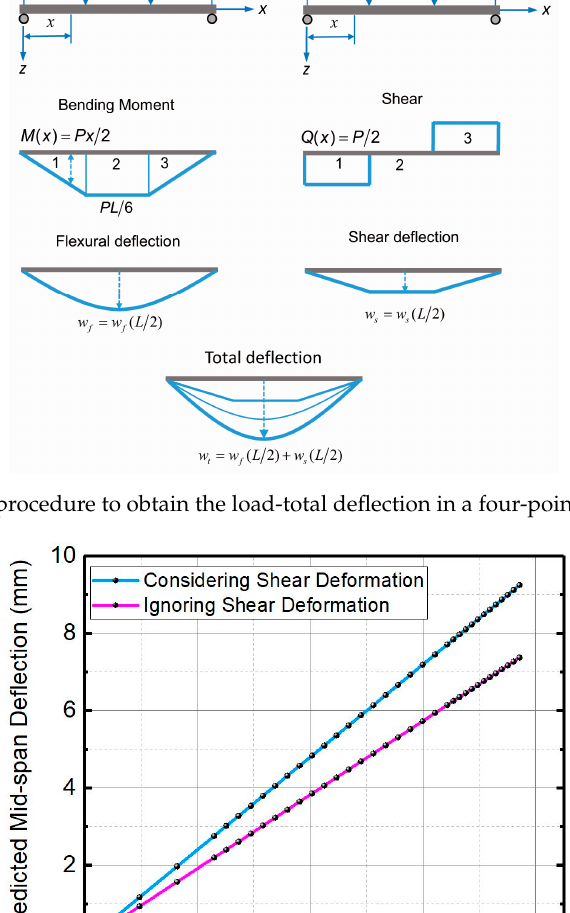
Figure 8. The relationship between the mid-span total deflection and the curvature.